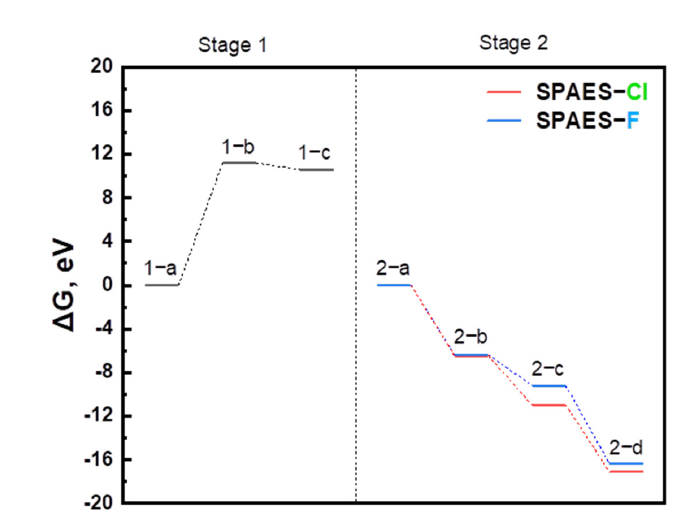
Figure 8. Gibbs free energy ( ∆ G ) for the SPAES synthesis reaction. In stage 1, BP(-OH) is substituted with BP(-OK), and in stage 2, the substituted BP(-OK) is reacted with DC(F)DPS or SDC(F)PDS with a halogen group.